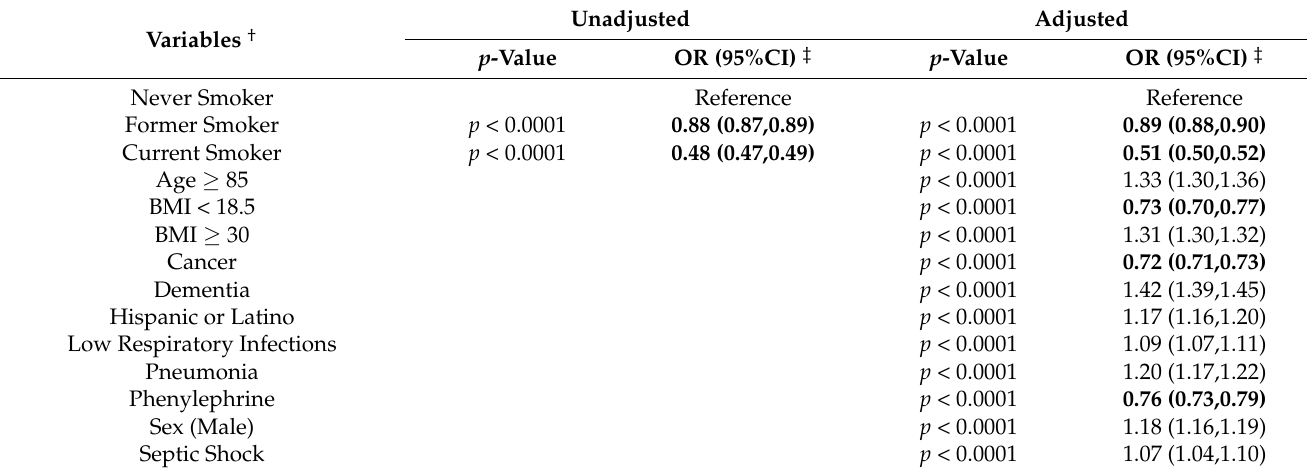
Table 3. Association between imputed smoking status and COVID-19 positivity for imputed